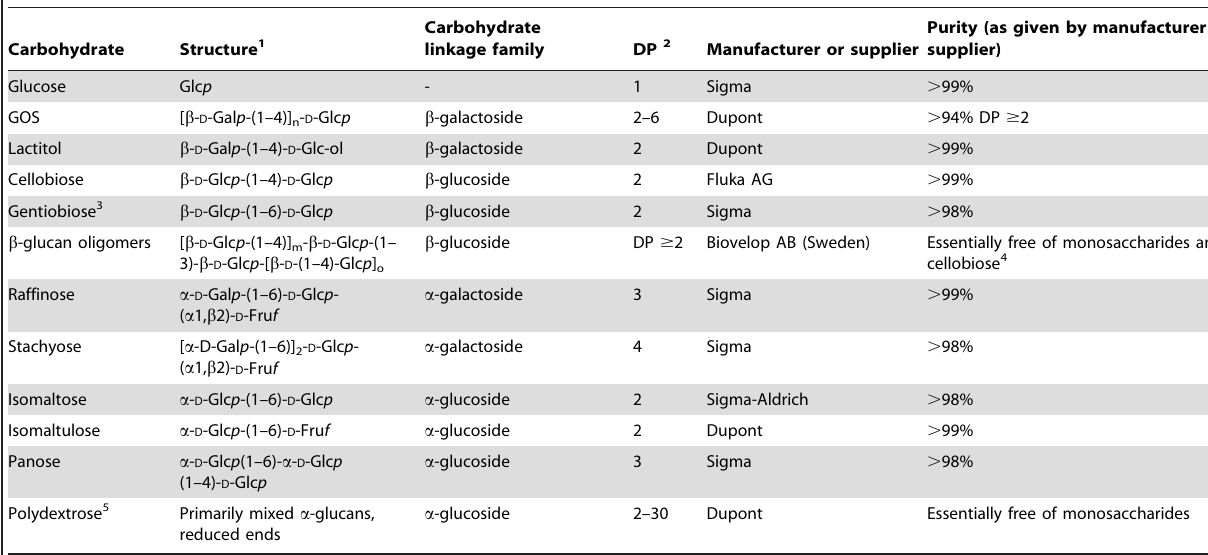
Table 1. List of carbohydrates used in this study.